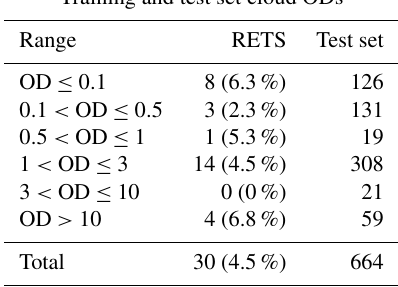
Table 4. Number of cloudy spectra, as a function of cloud OD inter- val, for elements belonging to the cloudy set of the RETS and to the test set for the tropical case. In the second column, in parentheses, the percentage value with respect to the total number of elements in the test set for the same OD interval is